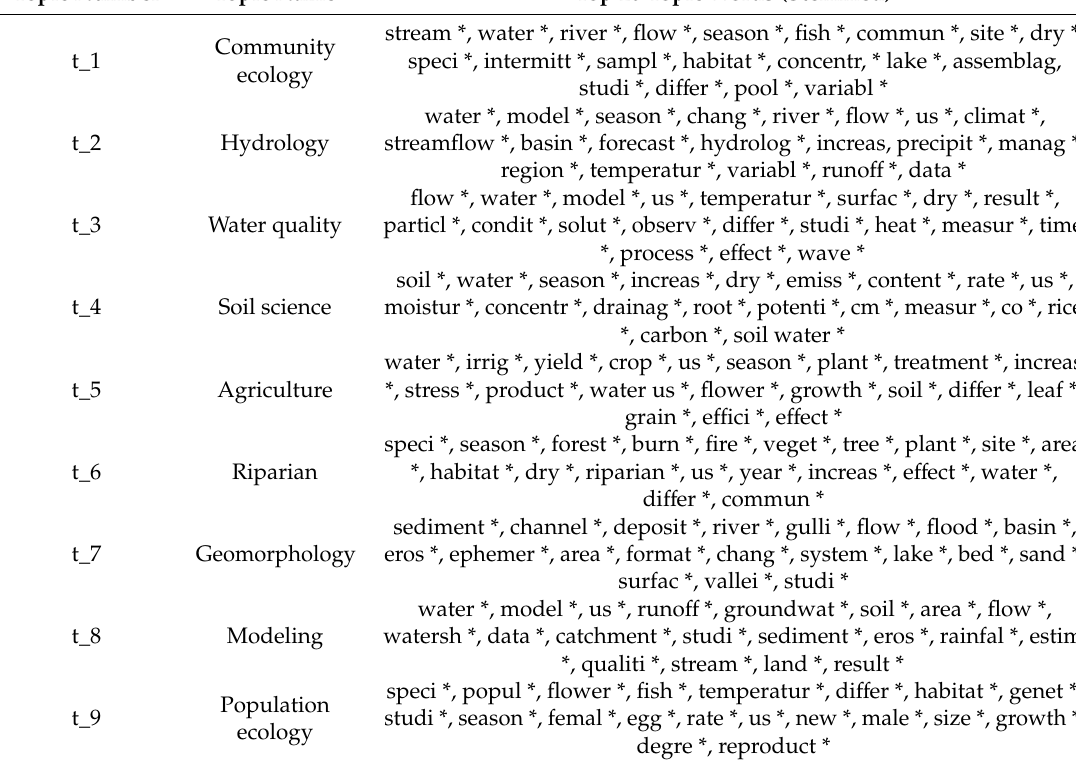
Table A2. Time Series Corpus